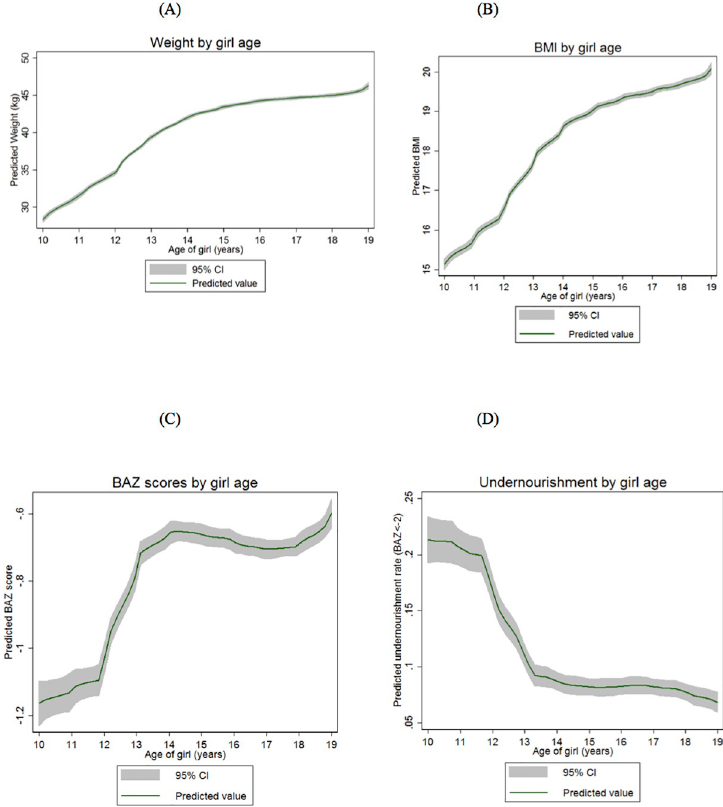
Fig 3. Age dynamics in weight of adolescent girls in Bangladesh. (A) Weight by girl age. (B) BMI by girl age. (C) BAZ scores by girl age. Z-scores express BMI as a number of standard deviations below or above the reference median value. (D) Undernourishment by girl age. Undernourishment is defined as BAZ < -2.